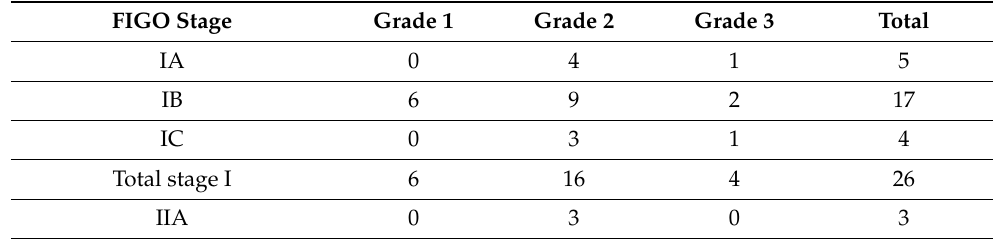
Table 4. Clinicopathological features (FIGO stage, grade and histologic subtype) of 39 patients with endometrial cancer (endometrioid and papillary-serous